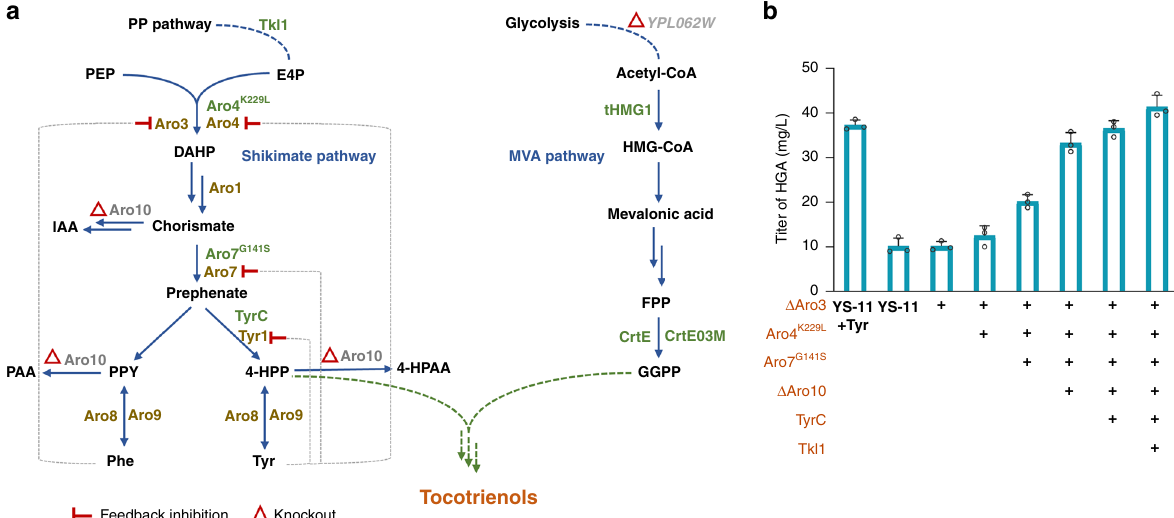
Fig. 5 Enhancement of precursor supply for tocotrienols production. a Strategy for modi fi cation of the shikimate pathway and MVA pathway to enhance precursor supply. The genes that are overexpressed are highlighted in green, and those knocked out are shown in gray. PP Pathway pentose phosphate pathway, PEP phosphoenolpyruvate, E4P D-erythrose-4-phosphate, DAHP 7P-2-dehydro-3-deoxy-D-arabino-heptonate, 4-HPP 4-hydroxy-phenylpyruvate, PPY phenylpyruvate, Tyr tyrosine, Phe phenylalanine, MVA pathway mevalonic acid pathway, HMG-CoA 3-hydroxy-3-methyl-glutaryl-CoA, FPP farnesyl pyrophosphate, GGPP geranylgeranyl diphosphate, IAA indole acetaldehyde, PAA phenylacetaldehyde, 4-HPAA 4-hydroxyphenylacetaldehyde, Tkl1 transketolase, Aro4 3-deoxy-D-arabino-heptulosonate-7-phosphate synthase, Aro7 chorismate mutase, Tyr1/TyrC cyclohexadienyl dehydrogenase, Aro10 phenylpyruvate decarboxylase, Aro8/Aro9 tyrosine aminotransferase, tHMG1 truncated 3-hydroxy-3-methyl-glutaryl reductase, CrtE geranylgeranyl diphosphate synthase. b Effect of stepwise optimization of shikimate pathway on HGA accumulation in YS-11. YS-11 + Tyr indicates YS-11 cultured with exogenously addition of tyrosine. All values presented are the means of three biological replicates, and error bars represent standard deviations. Source data are provided as a Source Data fi